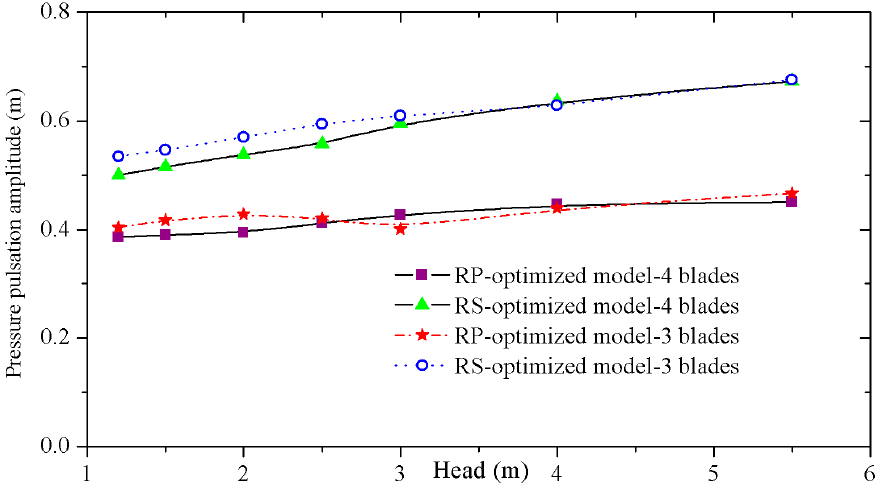
Figure 15. Pressure pulsation amplitudes with dominant frequency of 1 f n on blade points RP and RS for the flood turbine mode.